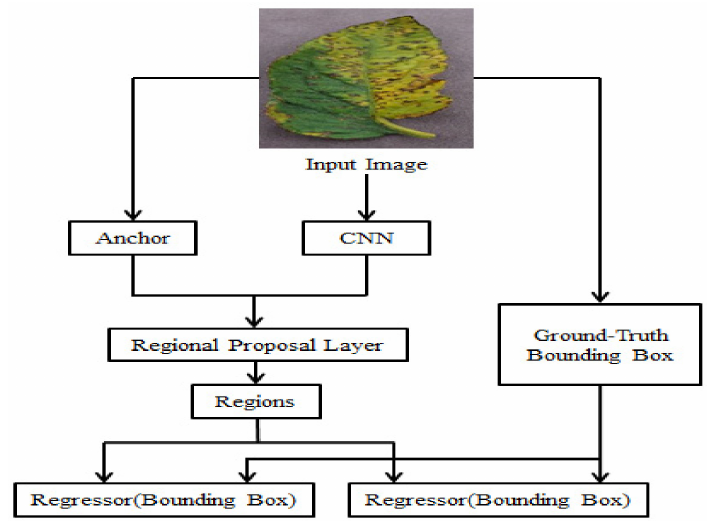
Figure 2. Faster R-CNN network